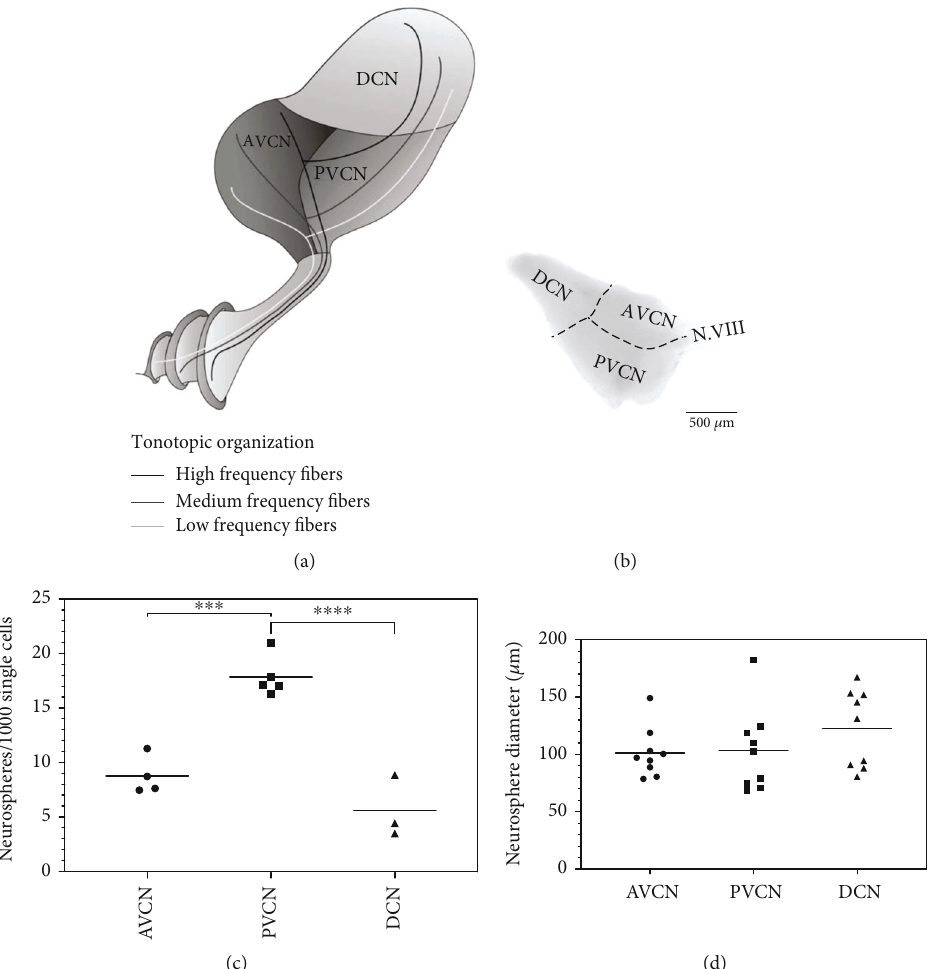
Figure 1: The dissected CN subnuclei form neurospheres in free- fl oating cell cultures in NSC medium. (a) Schematic overview of the topographical arrangement of the CN subnuclei, the auditory nerve, and the cochlea (AVCN=anteroventral cochlear nucleus; PVCN =posteroventral cochlear nucleus; DCN=dorsal cochlear nucleus). The tonotopic organization of the N.VIII fi bers is maintained in all subnuclei. (b) Microscopic re fl ected light image of a PND 9 CN preparation and labeling of the subnuclei and the cochlear nerve (N.VIII) before dissection. (c) Dissociated cells of the CN subnuclei form neurospheres in free- fl oating cell cultures under the in fl uence of EGF and bFGF. The quantitative evaluation after 30 days showed that the PVCN has the signi fi cantly greatest potential for the formation of neurospheres with 17 : 9 ± 1 : 9 ( n = 5 ; mean ± SD ) spheres per 1000 initially cultured single cells. (d) Evaluation of the neurosphere diameters after 4 weeks in free- fl oating cultures. The diameters averaged 101.2-122.6 μ m. No signi fi cant di ff erences were found between the subnuclei. Box plots show the median with the upper and lower quartiles, and whiskers mark the upper and lower maximum values; asterisks indicate the signi fi cance level: ∗ p < 0 : 05 , ∗∗ p < 0 : 005 , ∗∗∗ p < 0 : 001 , and ∗∗∗∗ p < 0 : 0001